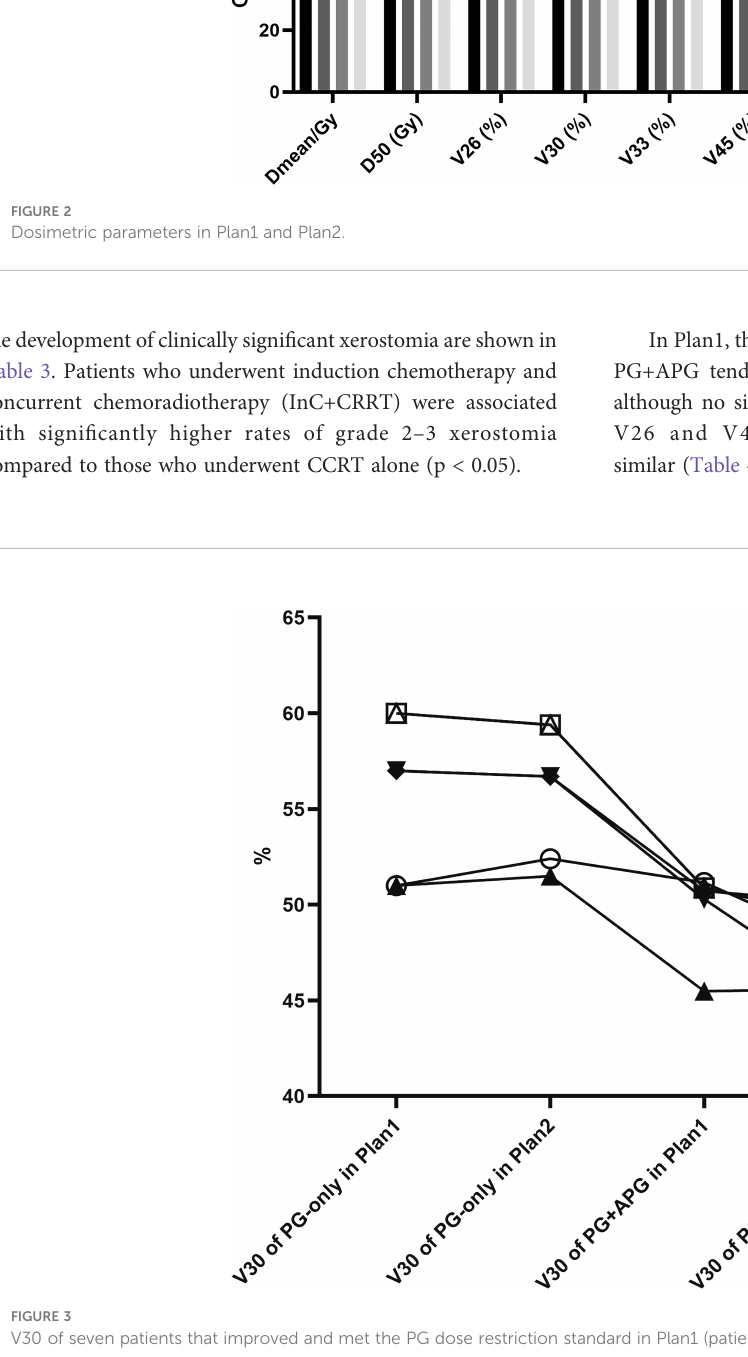
FIGURE 3 V30 of seven patients that improved and met the PG dose restriction standard in Plan1 (patients E – G) and